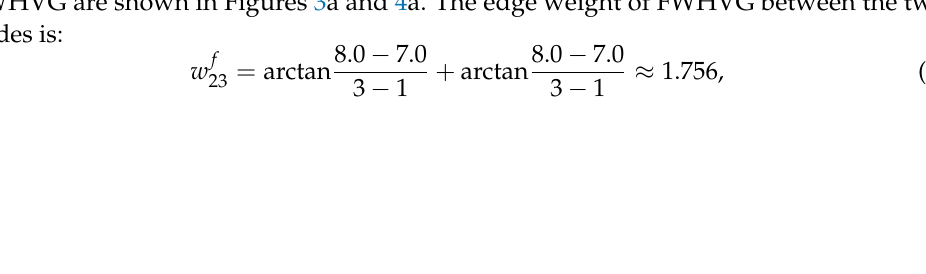
Figure 4. Graphical illustration of BWHVG of the time series. ( a ) Angle measurement of BWHVG; ( b ) Corresponding BWHVG of the time series.